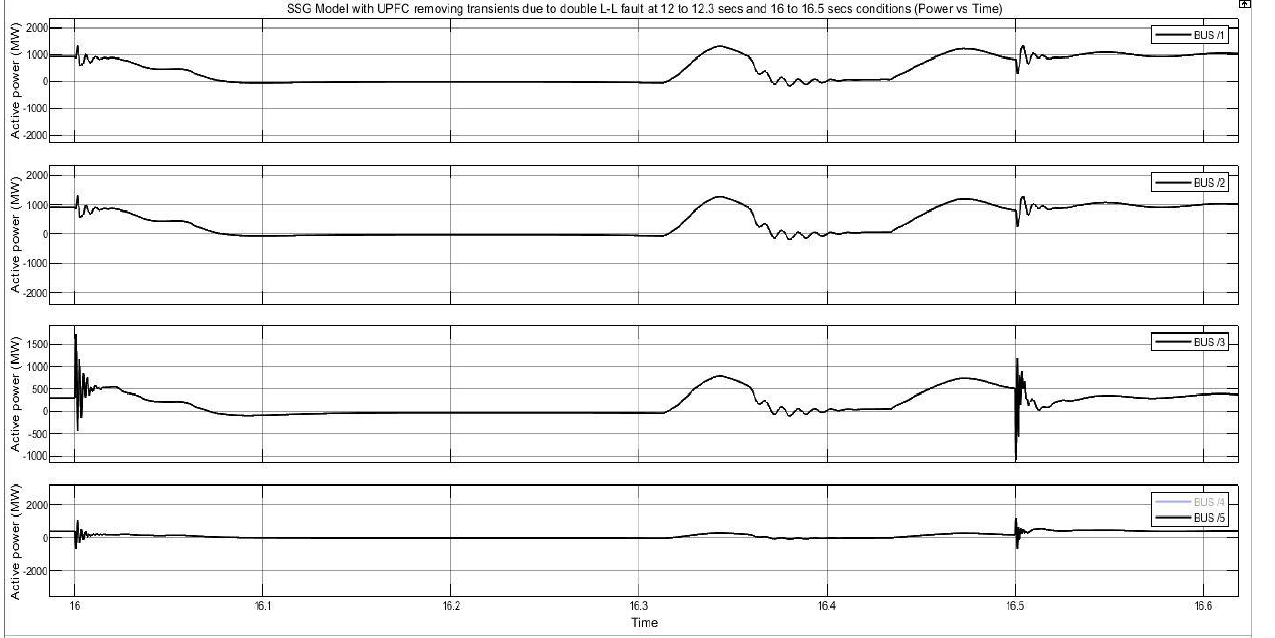
Figure 28. Transient stability being provided by UPFC after multiple double faults L-L introduced 16 to 16.5 s (Bus 1 to Bus 5).